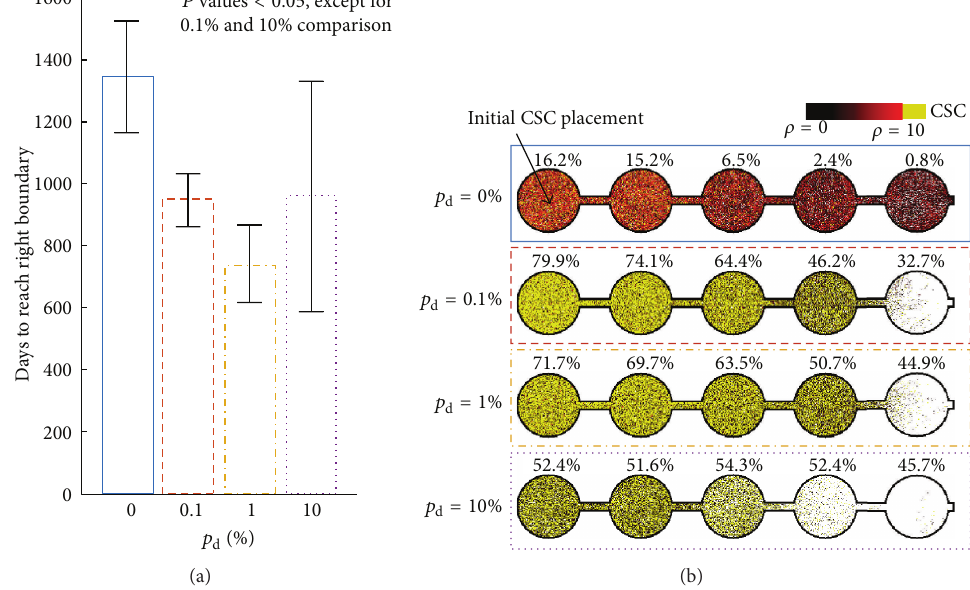
Figure 5: (a) Average ± SD number of days until the right boundary of 5-well plate is reached by cancer stem cell for different probabilities of plasticity event ( 𝑝 d ). (c) Simulation snapshots at the moment when first cancer stem cell reaches the right boundary for different probabilities of plasticity event ( 𝑝 d ). Percentages above each well indicate the fraction of cancer stem cells within each well. and thus reduced surface-to-volume ratio (Figure 4(c)). For